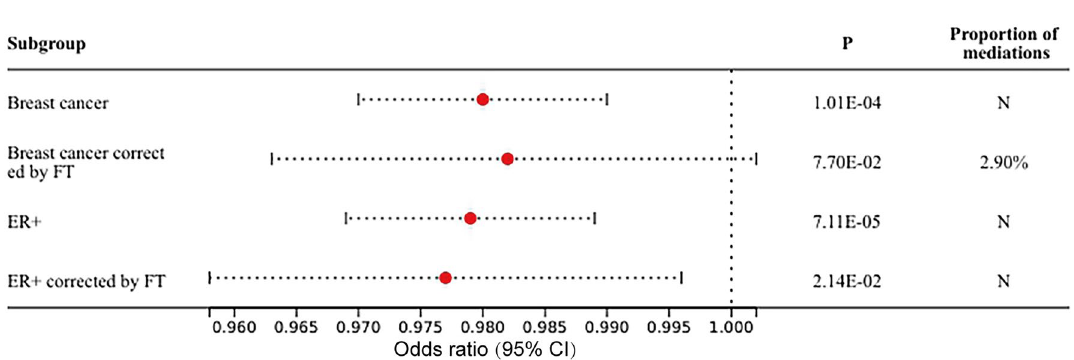
Figure 4. The forest plot and mediating ratios of breast cancer and its ER+ subtypes before and after FT adjustment on the bone density of the